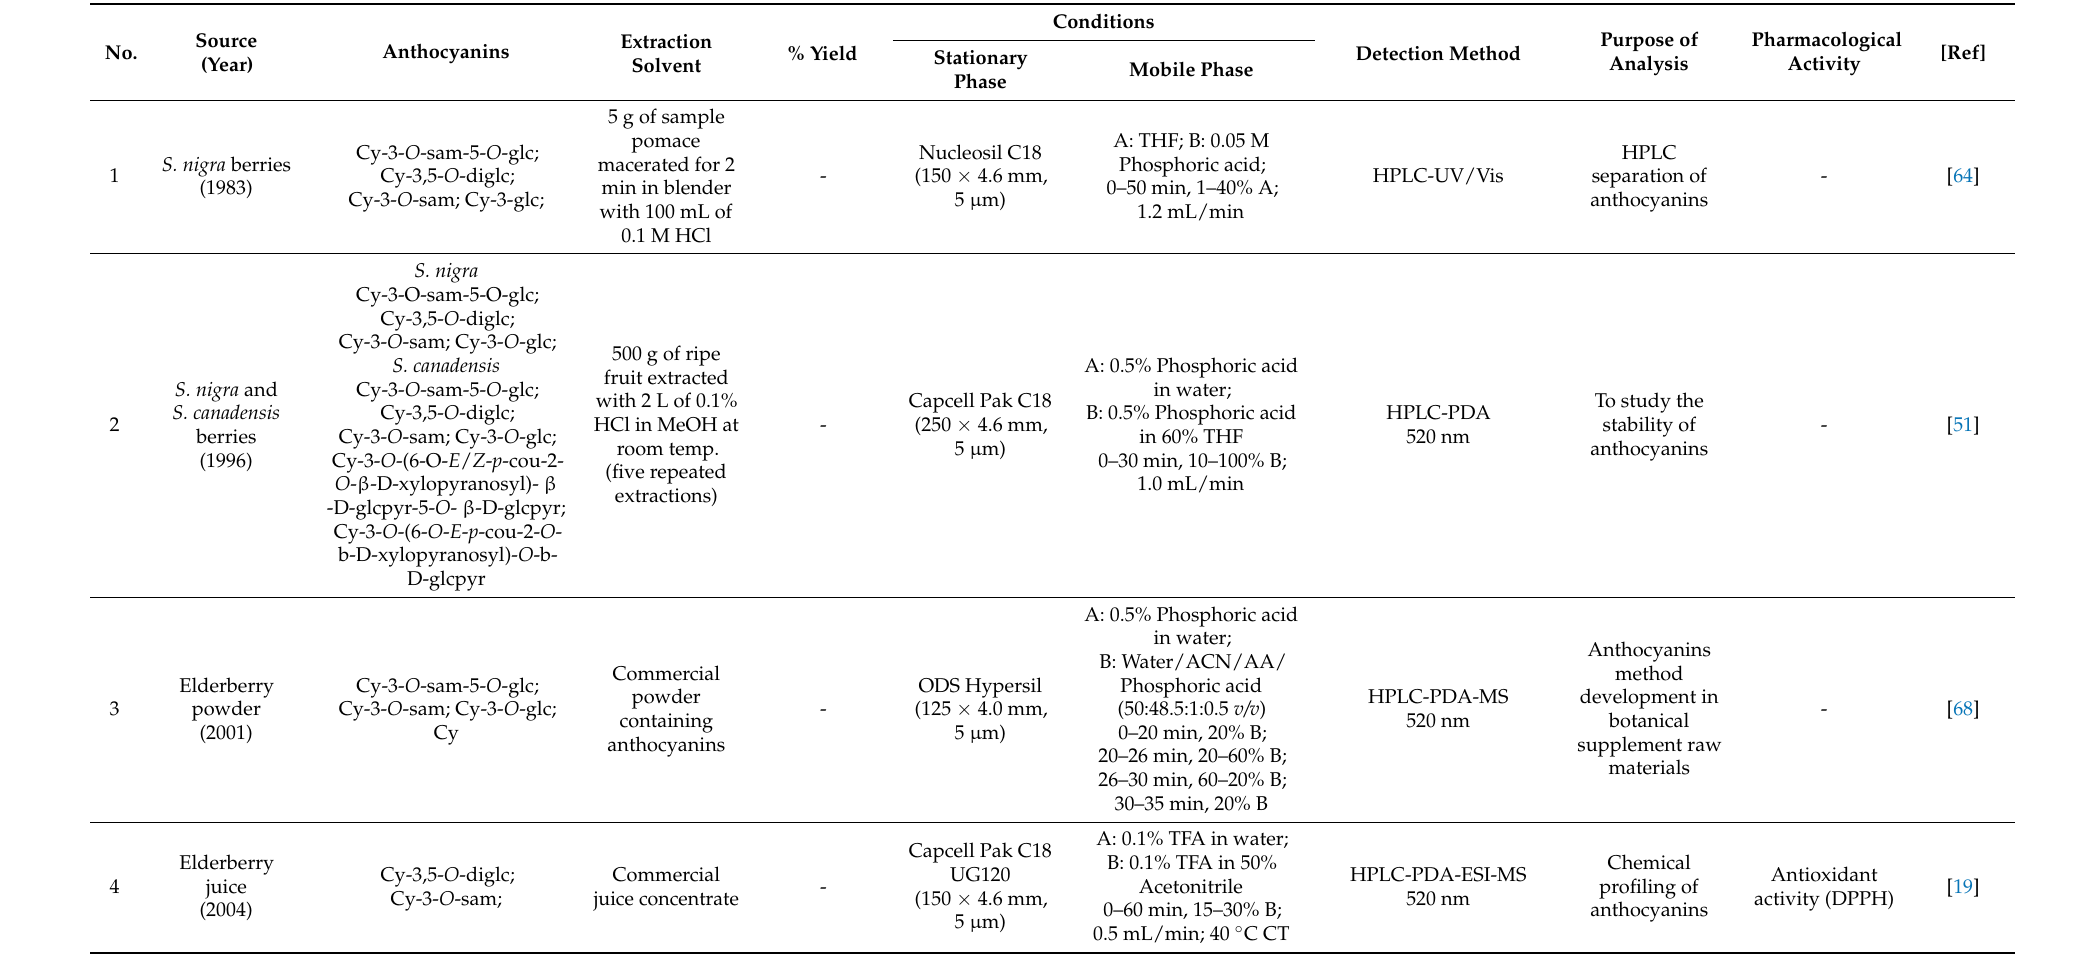
Table 3. List of analytical methods (HPLC/LC-MS) used to perform qualitative or quantitative analysis of Sambucus nigra anthocyanins, along with related commercial